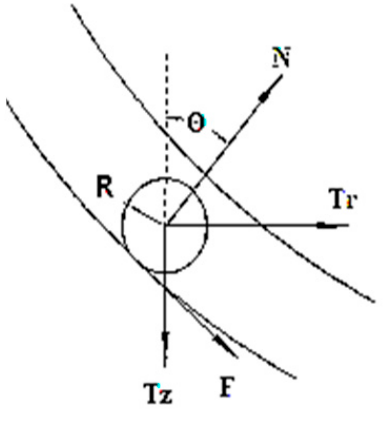
Figure 7. Simplified acting force on the main